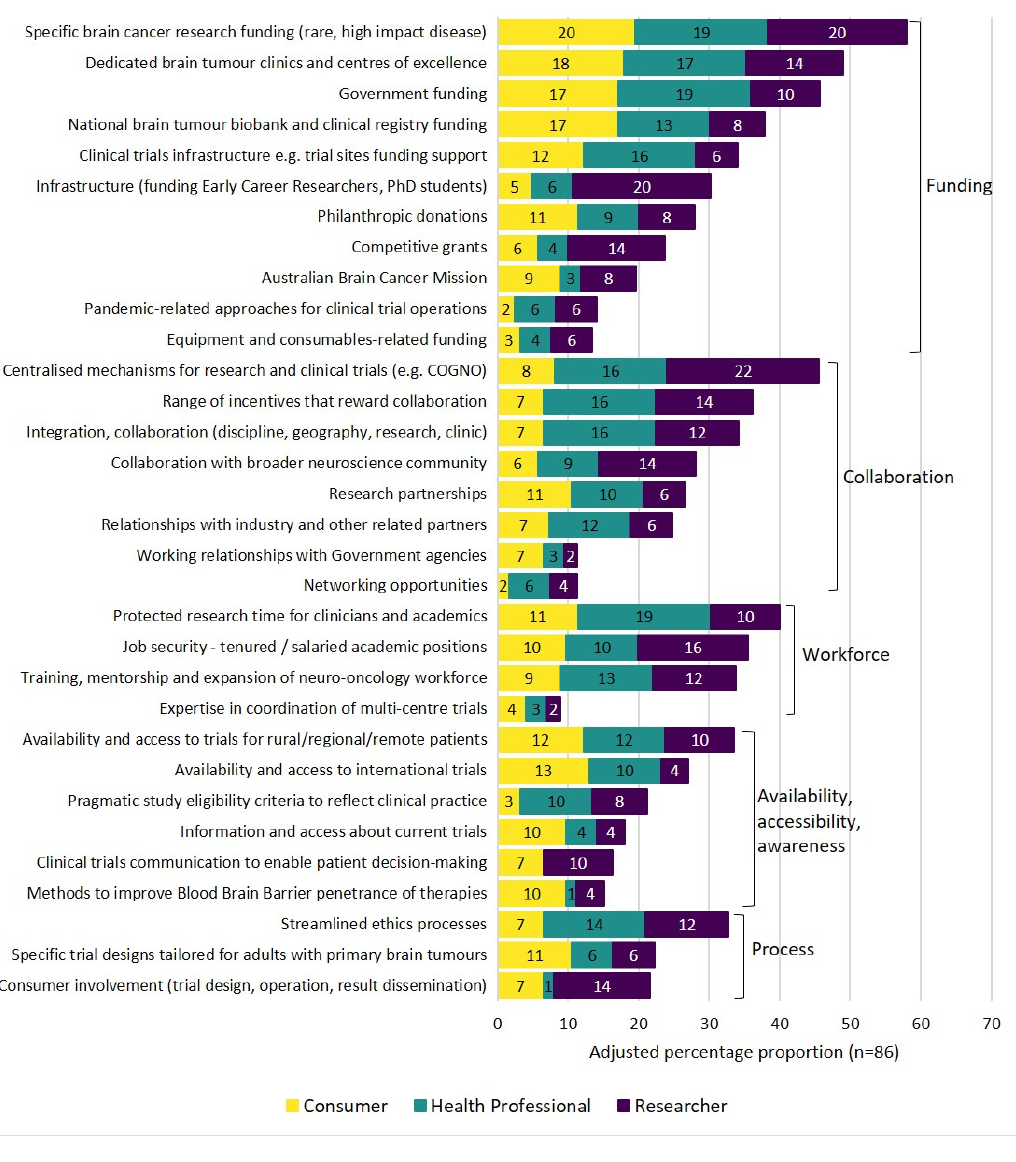
Figure 3. The adjusted proportion of participants by sub-group who selected research enablers in the top ten.